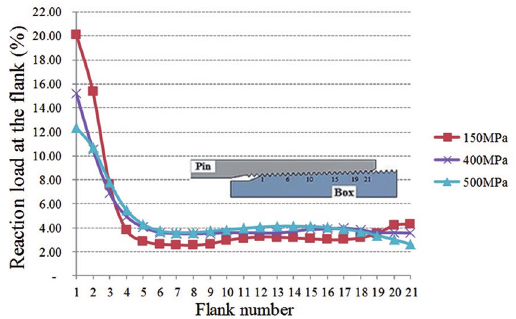
Figure 7: Results of load distribution over the flanks of API Short Round casing connection.